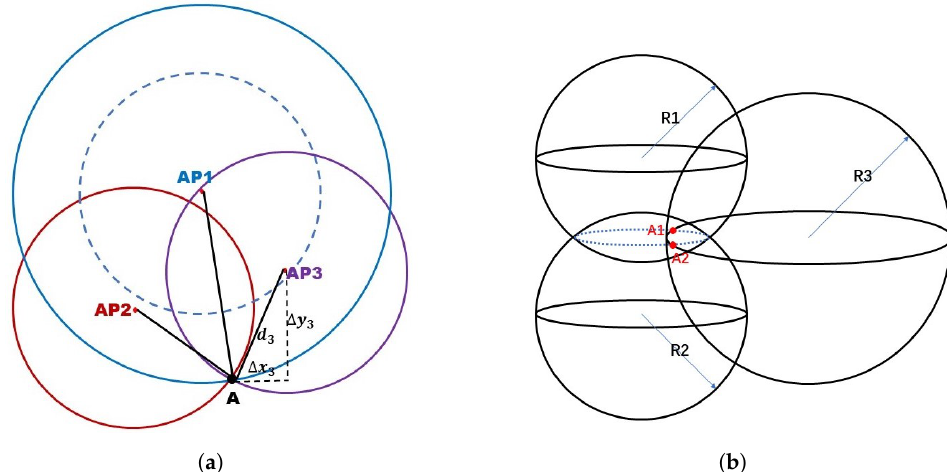
Figure 1. Trilateration models. ( a ) Ideal (solid line) model and practical error-tolerated (dash line) model for 2D trilateration. ( b ) Error-tolerated 3D trilateration